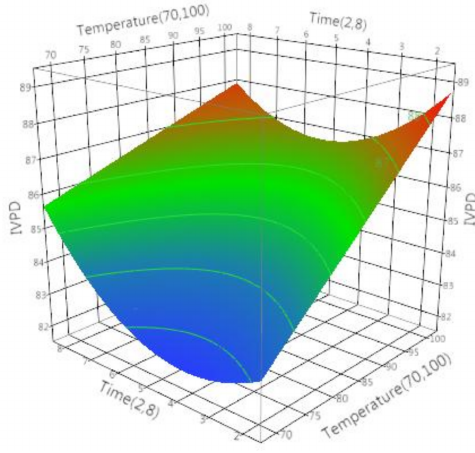
Figure 1. Effect of time (min) and temperature ( ◦ C) on in vitro protein digestibility (IVPD) of soymilk during microwave